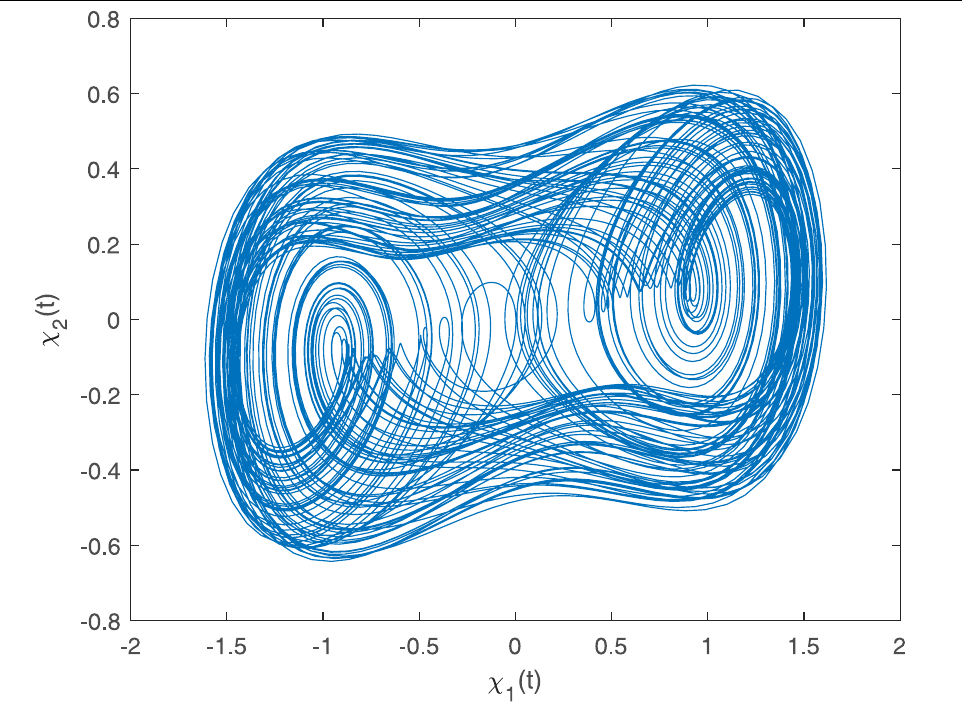
Fig 1. The healthy CACS phase portraits under ϖ ( t ) = 0 with no control input.